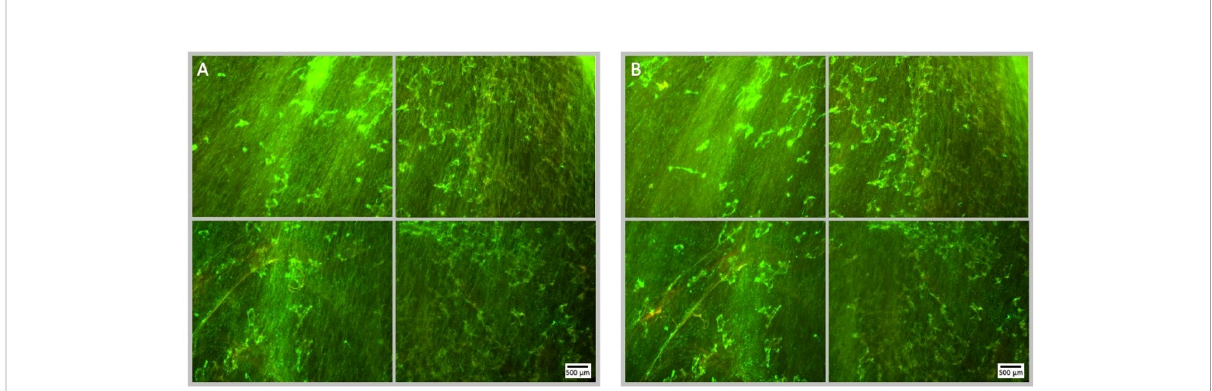
FIGURE 7 Fluorescence microscopy images of a Syto9 (green) and PI (red) stained P. aeruginosa bio fi lm; the images are representative of a no ultrasound treatment control where MBs were applied with 4 µg/mL sub-inhibitory gentamicin, but not stimulated with ultrasound. Each panel is comprised of four images, which provide an overview of the bio fi lms gross architecture in a 1 cm 2 area at the centre of the Ibidi ® dish. Panel (A) , depicts the pre-treatment images of the 1 cm 2 area of bio fi lm, captured prior to the administration of the MB-antibiotic suspension; scale bar is equal to 500 µm. Panel (B) , depicts the post-treatment images of the same 1 cm 2 area of bio fi lm, captured after the administration and removal of the MBs-antibiotic suspension from the Ibidi ® dish. There is no visibly discernible decrease in cell viability assessed by PI, subsequent to the administration of gentamicin at 4 µg/mL; this further validates that the concentration used is sub-inhibitory.